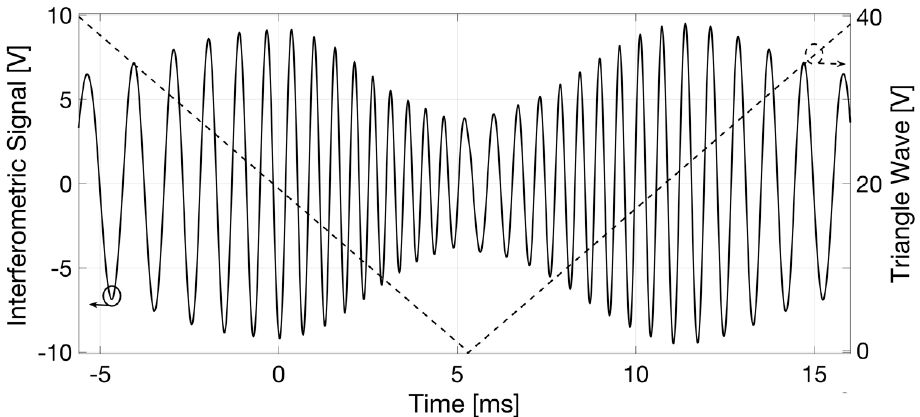
Figure 4. Interferometric signal (black continuous trace, left axis) and triangle driving wave (black dashed trace, right axis) as a function of time. The interferometric fringes appear amplitude modulated by a gaussian visibility function, as expected using the SLED due to its Gaussian emission spectrum.